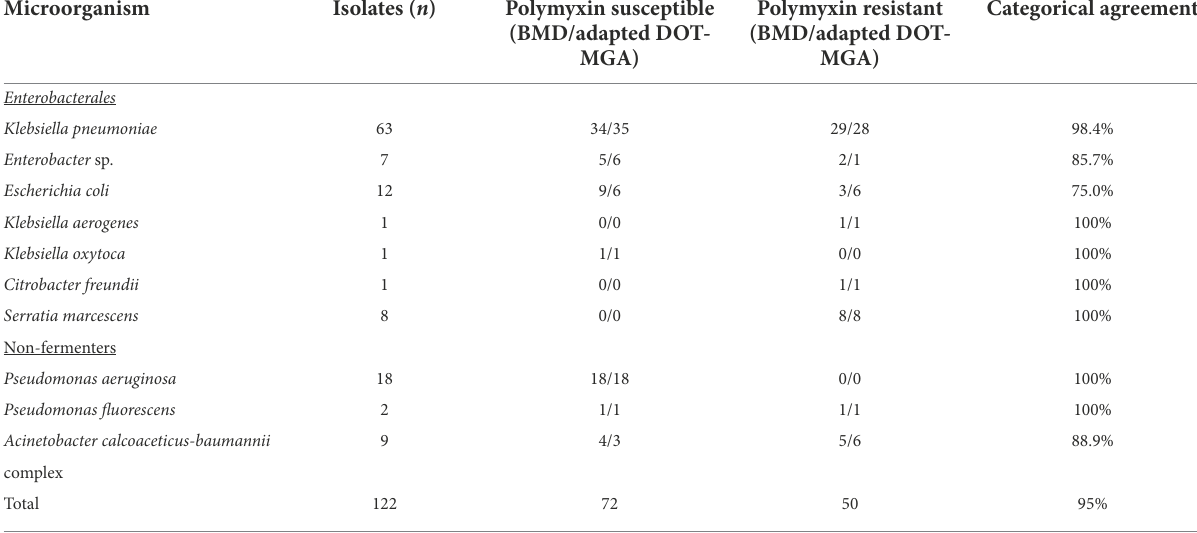
TABLE 1 Comparison of polymyxin B susceptibility of adapted DOT-MGA from colonies grown on agar plates with BMD. Microorganism